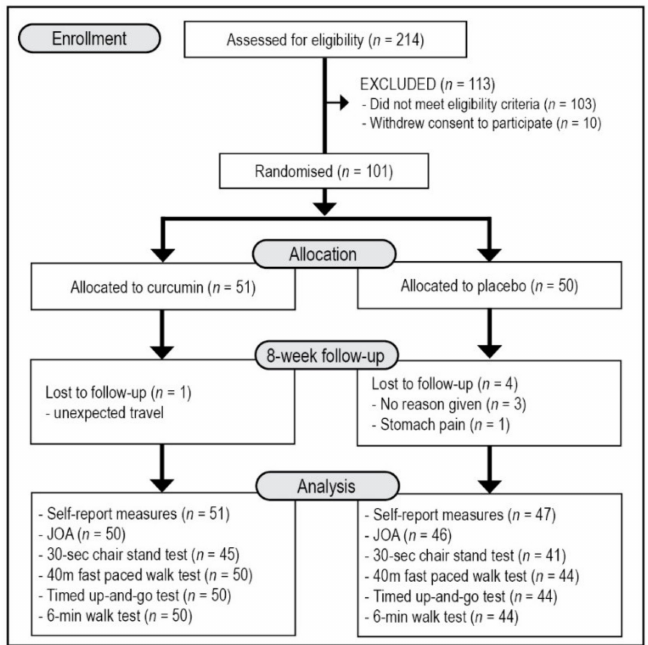
Figure 1. Systematic Illustration of Study Design. JOA = Japanese Orthopaedic Association Score for Osteoarthritic Knees, KOOS = Knee Injury and Osteoarthritis Outcome Score, PROMIS-29 = Patient- Reported Outcomes Measurement Information